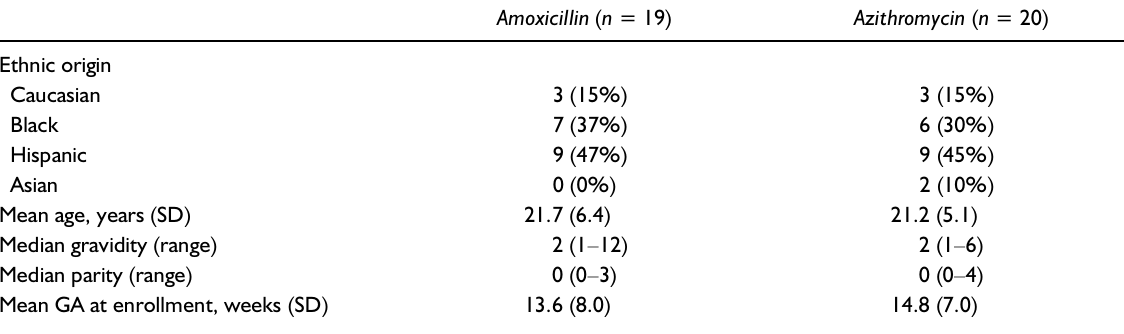
Table 1 Demographic and reproductive characteristics of patients by treatment